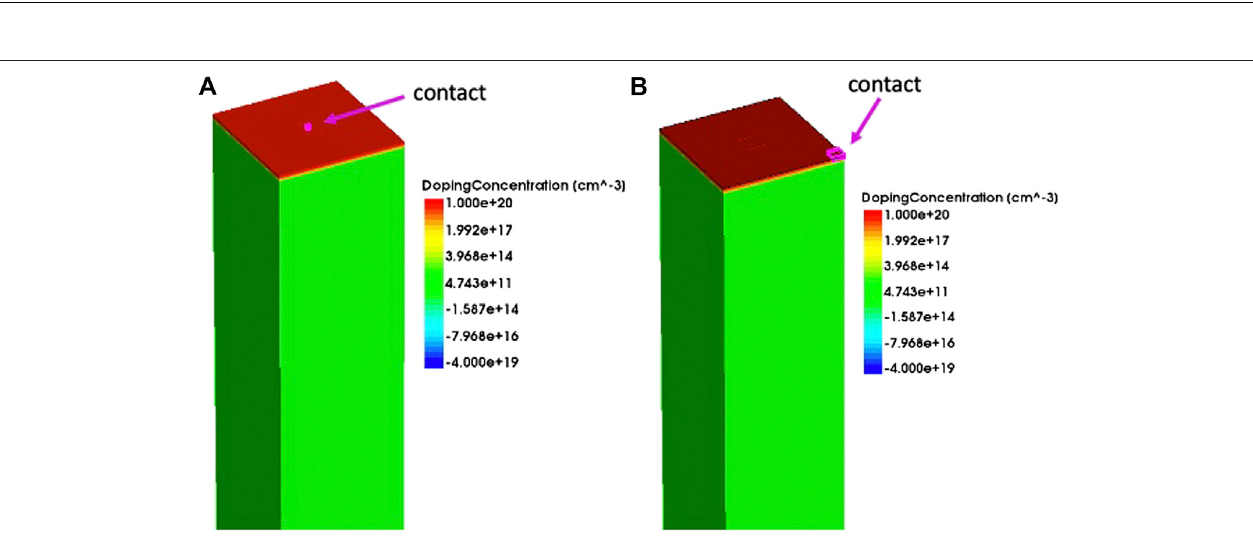
FIGURE 7 | PIN diode structure used for TCAD simulations of x-ray charge collection. (A) (left) has a contact (shown in pink) in the center, where the simulated photon is absorbed. (B) right has an oxide interface over the simulated photon absorption location, with an electrical contact (pink square) in the corner.